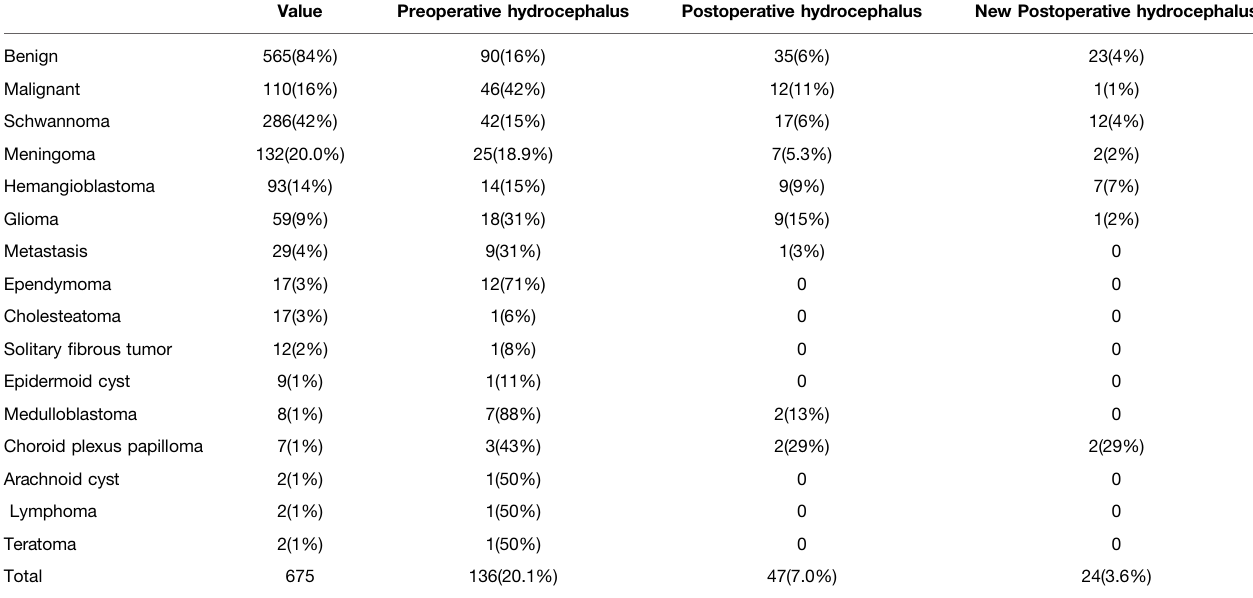
TABLE 3 | Details of the nonprophylactic-EVD